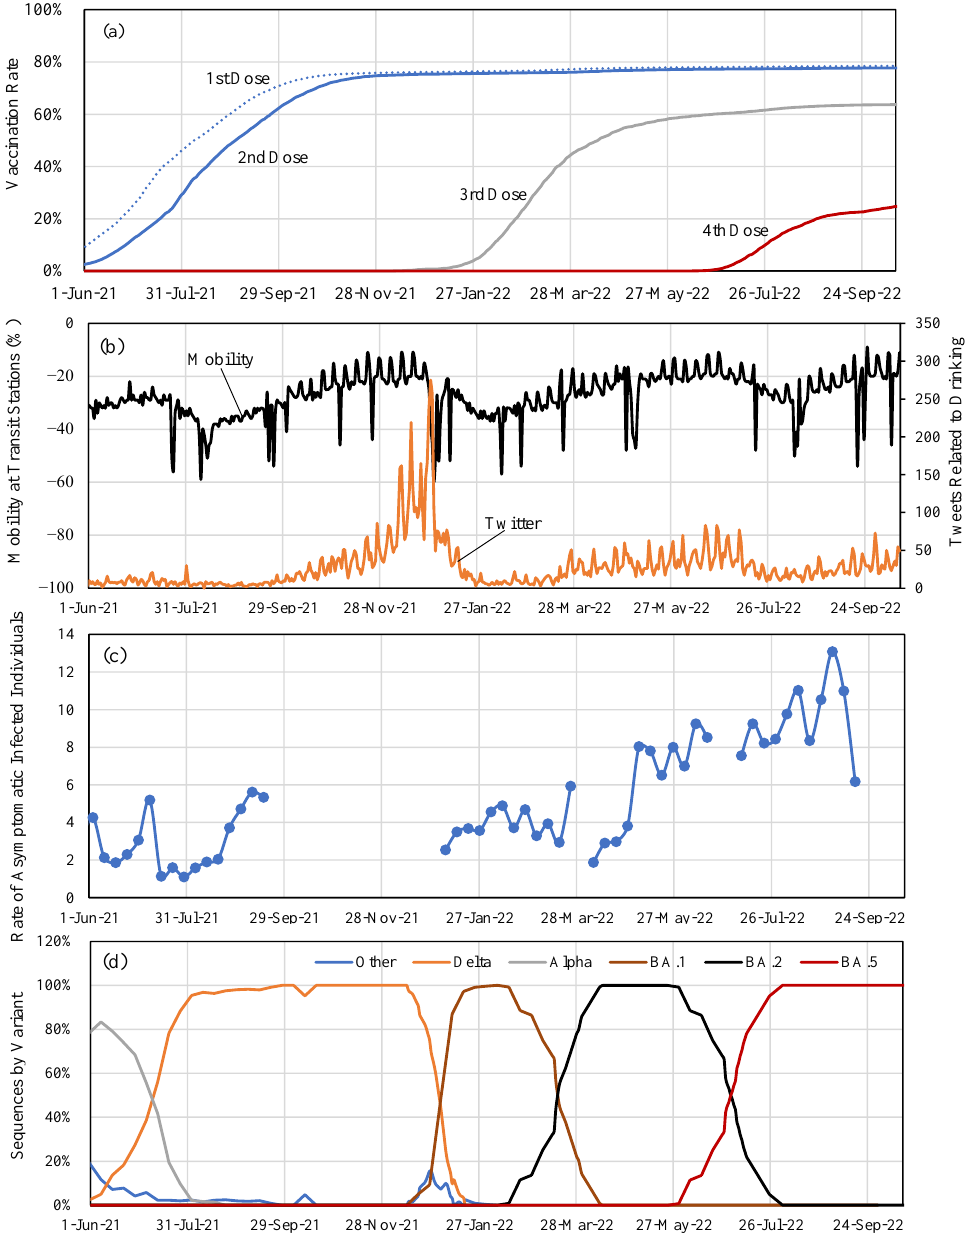
Figure 1. Time series of the ( a ) vaccination rates, and ( b ) the mobility at transit stations and the number of tweets related to drinking on Twitter. ( c ) Rate of asymptomatically infected individuals to reported positive cases. Missing period data are from 28 March to 3 April 2022, and 27 June to 3 July 2022. Periods with <500 average daily positive cases are not shown owing to a high level of uncertainty. ( d ) Time sequences by SARS-CoV-2 variants.